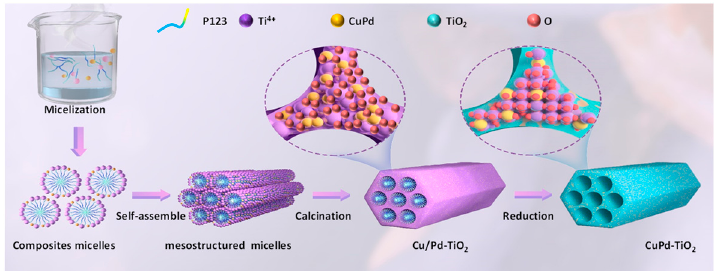
Figure 1. Illustration of the synthesis of a CuPd-TiO 2 (CPT) catalyst.